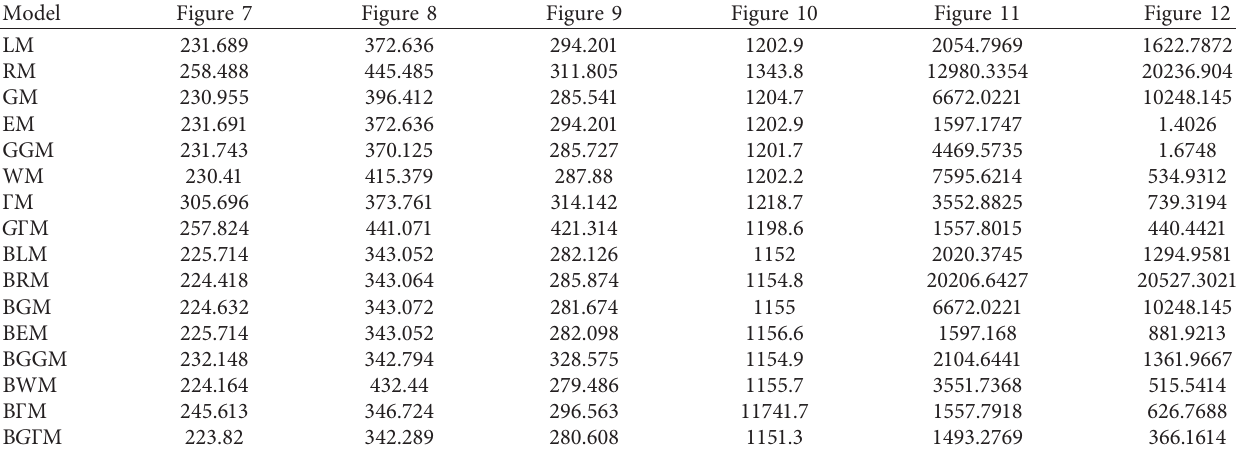
Table 5: The corresponding − 2 L values of models fitted to real data in Figures 7–12. Model